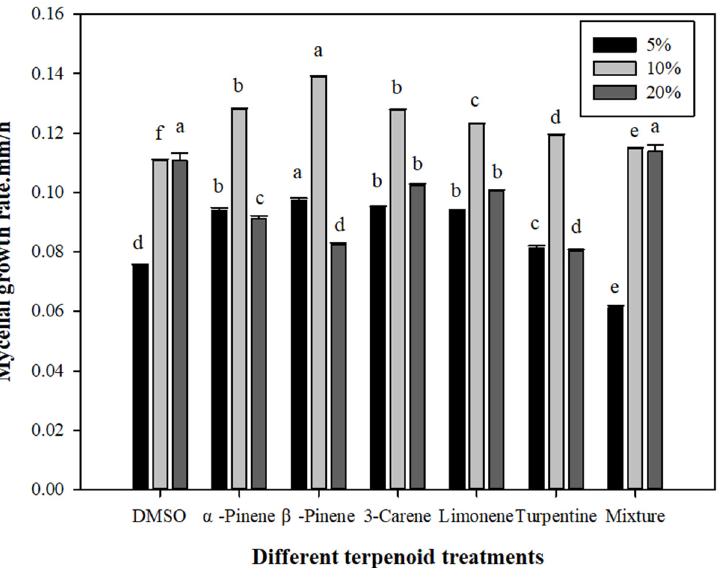
Figure 5. Effects of different terpenoid treatments on mycelial growth rate. Mycelial growth rate is expressed as the mean ± S.E, and the different letters above the bars indicate significant differences (p < 0.01, Tukey’s HSD test). Showing 5%, 10% and 20% concentration treatment, 7 biological replicates (DMSO as CK) and 5 technical replicates for each biological treatment.